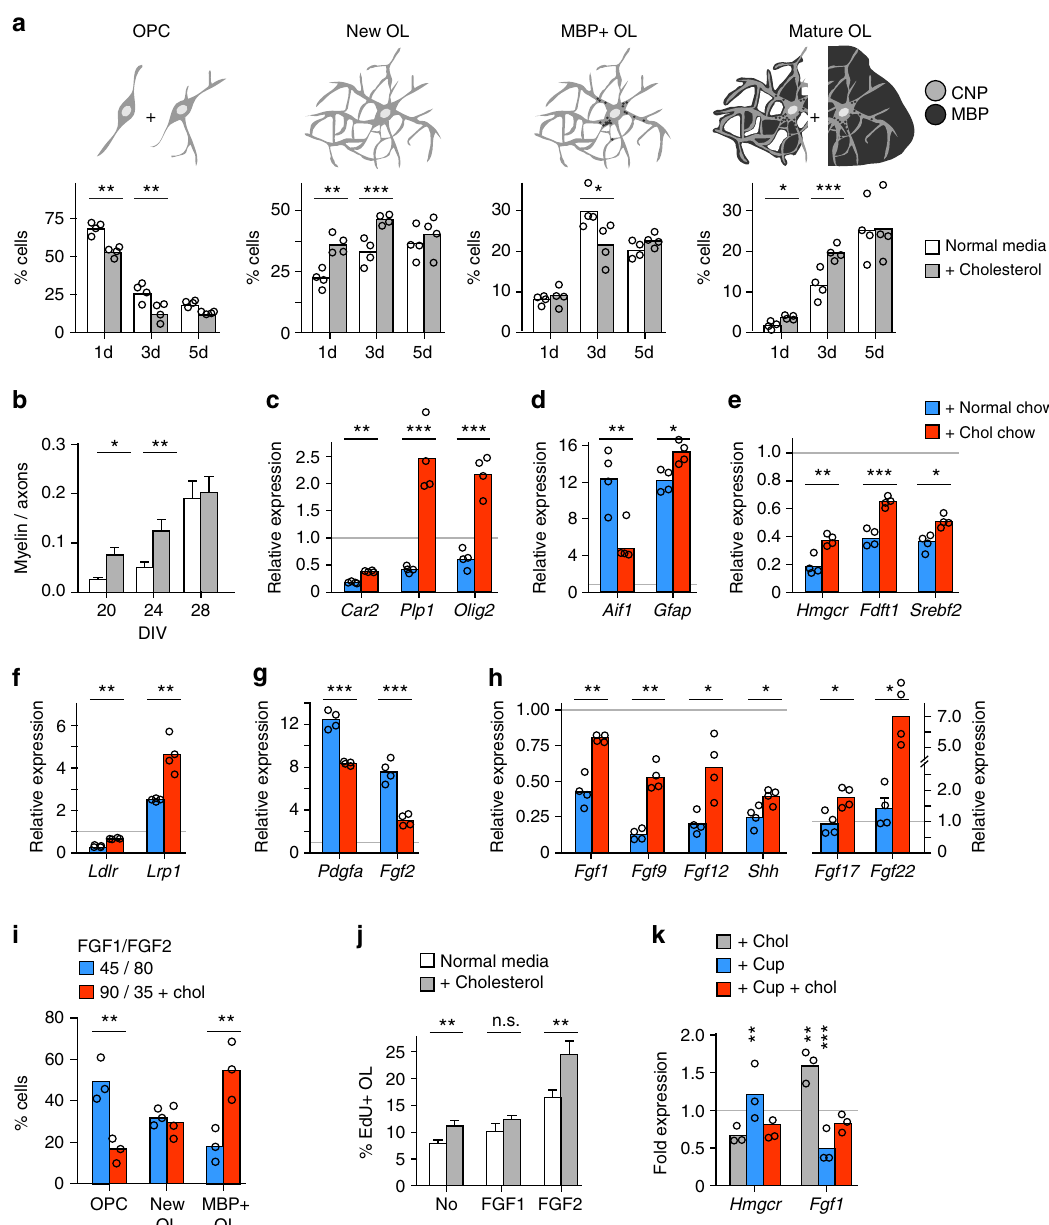
Figure 7 | Cholesterol alters the expression profile of growth factors. ( a ) Differentiation time course of OPCs in oligodendroglial enriched cultures in the presence or absence of cholesterol supplementation (bars represent mean of n ¼ 4 cultures with individual data points). Drawings illustrate chosen categories of oligodendrocyte differentiation. In each category, significance was assessed by two-way ANOVA and Sidak’s post tests. ( b ) Myelination at 20–28 days in vitro (DIV) in myelinating cocultures in the presence or absence of cholesterol ( n ¼ 5–9 cultures). Myelin segments and axons were counted (see Supplementary Fig. 8b; two-way ANOVA and Sidak’s post tests). ( c – h ) Quantitative RT-PCR analysis on dissected corpus callosi from mice after ‘induced remyelination’ (4 þ 1 weeks) and controls determining the expression of oligodendrocyte and myelin related genes ( c ; Car2, Plp1, Olig2 ), marker genes for microglia ( Aif1 ) and astrocytes ( Gfap ) ( d ), genes involved in cholesterol synthesis ( e ; Hmgcr, Fdft1, Srebf2 ) and uptake ( f ; Ldlr, Lrp1 ), and growth factors downregulated ( g ; Pdgfa, Fgf2 ) and upregulated by cholesterol supplementation ( h ; Fgf1, Fgf9, Fgf12, Shh, Fgf17, Fgf22 ). Bars represent the means ( n ¼ 4 animals) with individual data points (Student’s t tests) normalized to untreated control mice (set to 1, grey line). ( i ) Differentiation of rat oligodendroglial cells in cultures supplemented with FGF1 and FGF2 (concentrations in ng per ml as indicated) in the presence or absence of cholesterol. Bars represent mean percentage of cells in each category of n ¼ 3 cultures (two-way ANOVA with Sidak’s post test). ( j ) Proliferation of OPCs in response to growth factors and cholesterol. OPCs were cultured in the presence or absence of the growth factors (100ngml (cid:2) 1 ) FGF1 or FGF2 with or without cholesterol for 24h. Data are mean EdU positive cells of all oligodendroglial cells ± s.e.m. ( n ¼ 13 (no GF, FGF2) or n ¼ 7 (FGF1) cultures of individual rats; Student’s t -tests). ( k ) Quantitative RT-PCR on primary astrocytes treated with cuprizone (cup) with or without cholesterol (chol) supplementation. Bars represent the mean of n ¼ 3 independent experiments with individual data points compared with untreated cultures (set to 1, grey line; one-way ANOVA with Sidak’s post tests. Asterisks represent significant differences with * P o 0.05; ** P o 0.01; *** P o